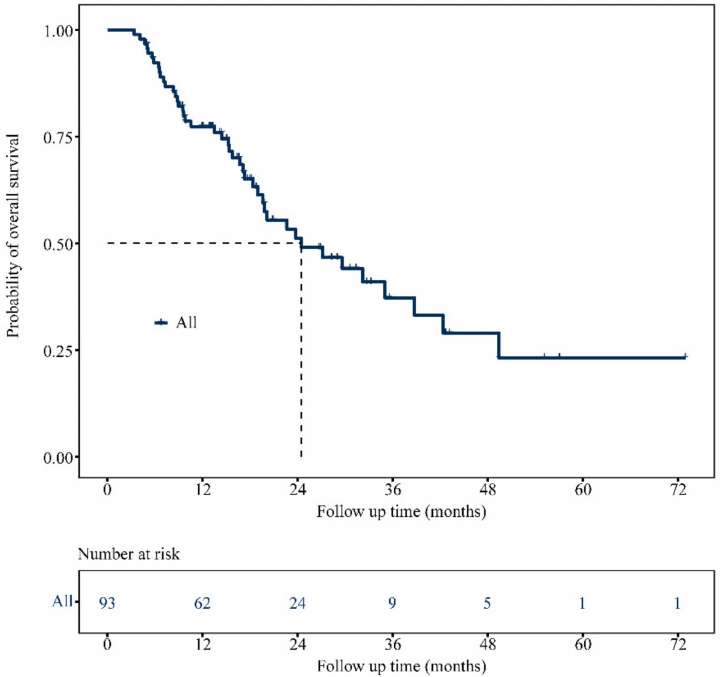
Figure 2. Kaplan–Meier analysis of OS in all mCRC patients with the BRAF V600E mutation. Patients who underwent LRIs showed significantly longer OS than those treated